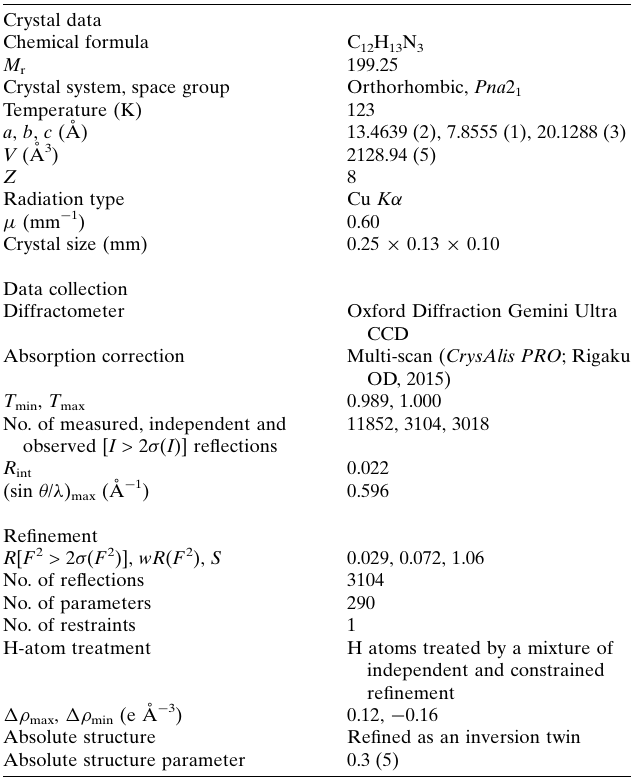
Table 2 Experimental details. Crystal data Chemical